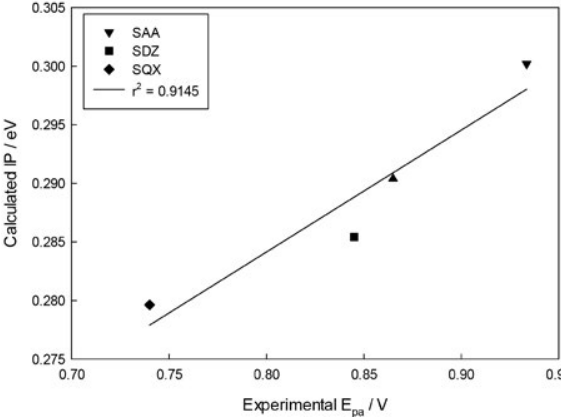
Figure 2. Correlation plot between the calculated IP (eV) and ex- (V) for SA perimental E pa